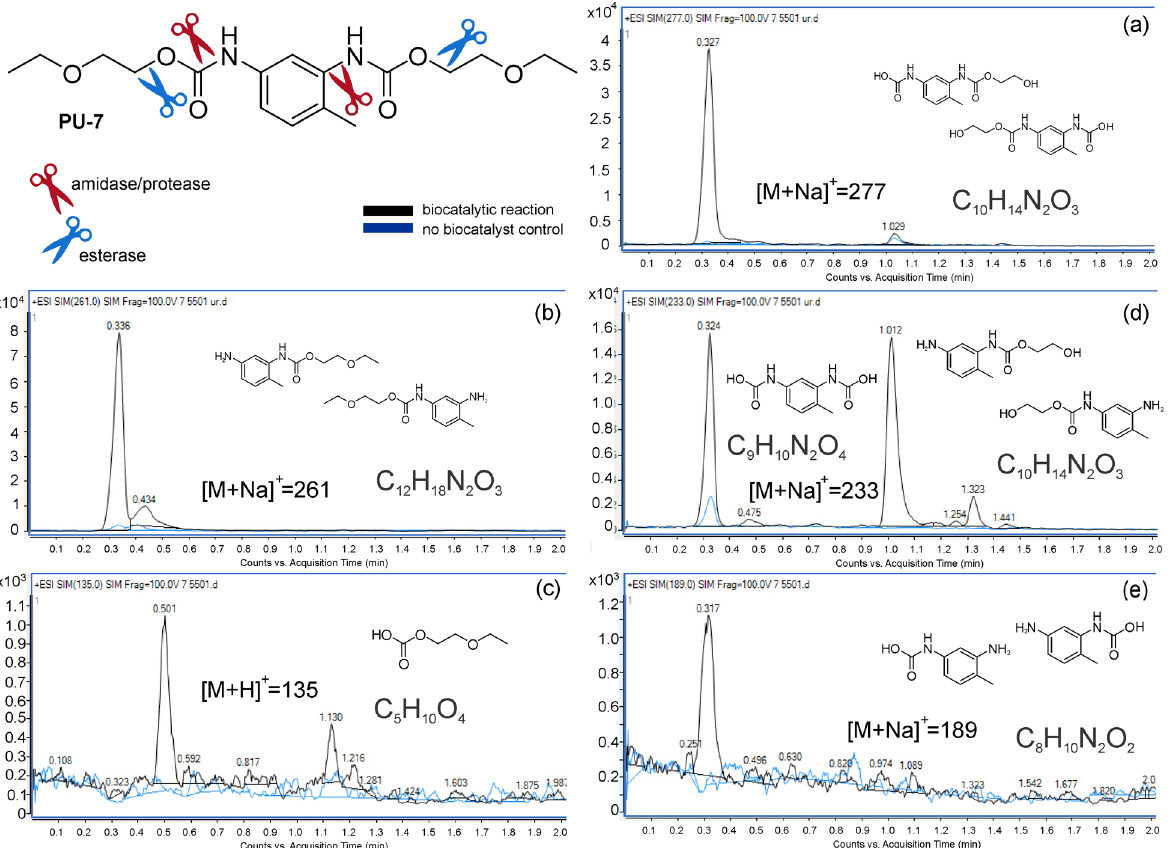
Figure 4. Biocatalytic reactions using PU-7 as substrate and resting whole cells of A. mediterranei ISP5501 as biocatalyst. Control reactions containing no biocatalysts are presented as a blue line. Products were identified using MS. The esterase activity generated two compounds of the molecular formula C 10 H 14 N 2 O 3 ( a ), the amidase activity generated two compounds of the molecular formula C 12 H 18 N 2 O 3 ( b ), and one compound of the molecular formula C 5 H 10 O 4 ( c ), while the activity of both types of enzymes generated two compounds of molecular formula C 10 H 14 N 2 O 3 and one of C 9 H 10 N 2 O 4 ( d ) and two compounds of the molecular formula C 8 H 10 N 2 O 2 ( e ).